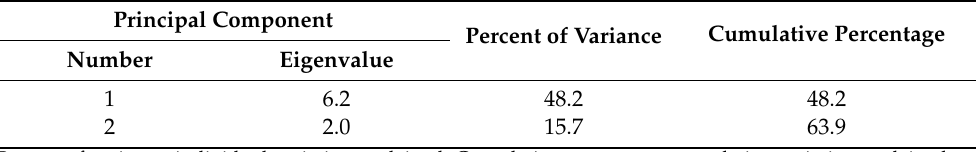
Table 5. Principal components (PC) of the phenolics evaluated.